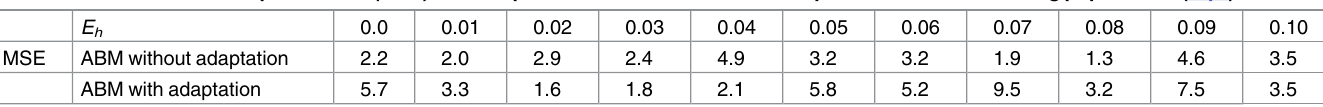
Table 2. Values of the mean squared error (MSE) of the exponential fits to the number of replicate runs with surviving populations (Eq 9). E h 0.0